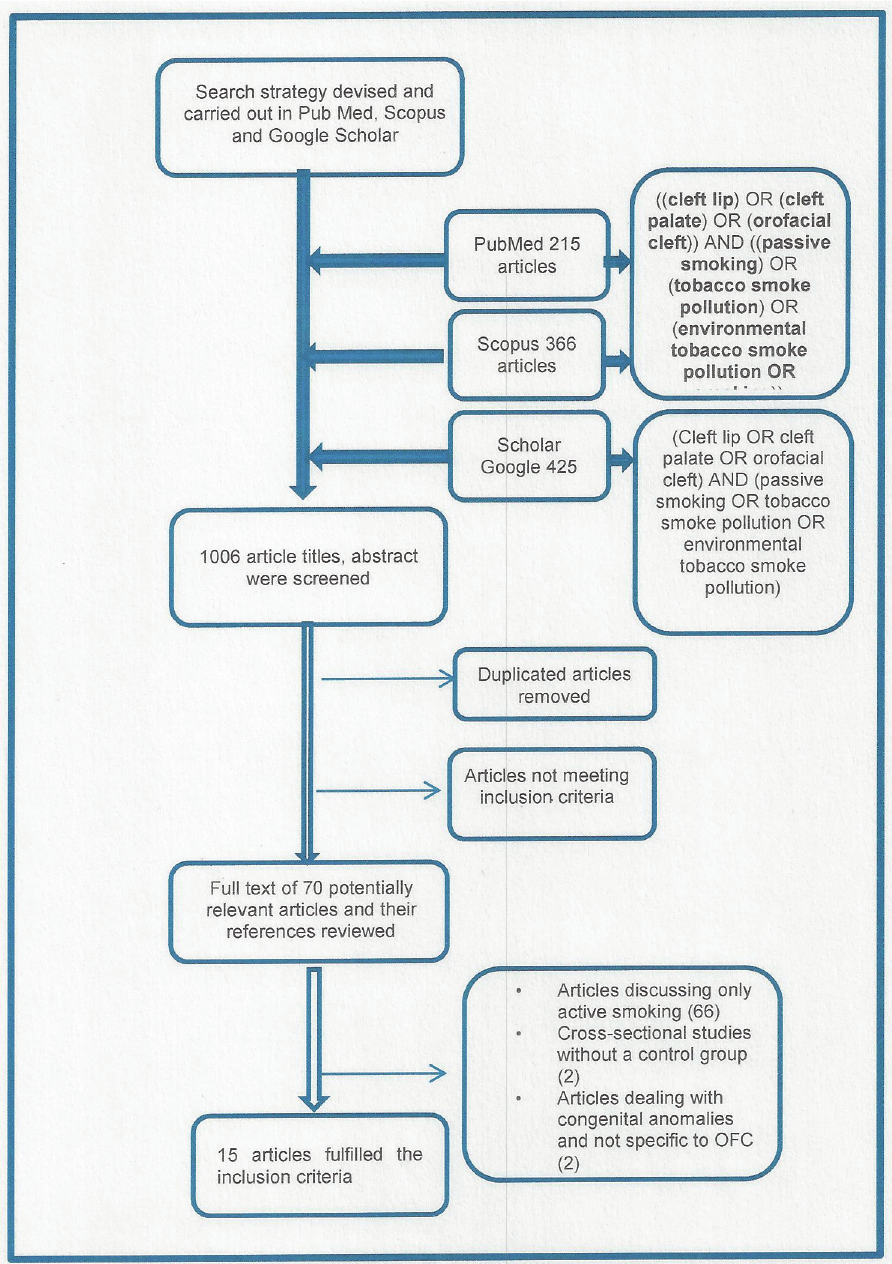
Fig 1. Flow diagram of study selection